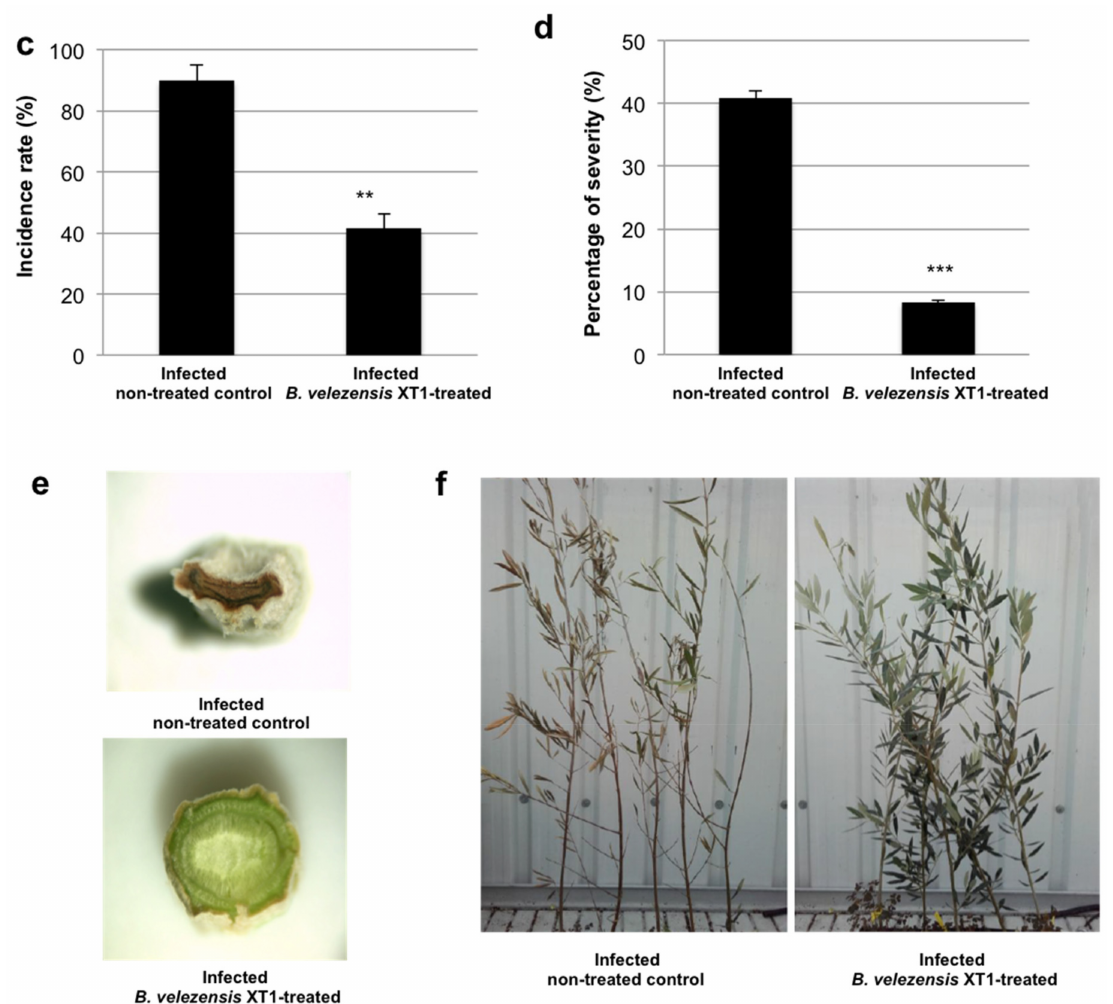
Figure 3. Prevention of Verticillium wilt on young olive trees by Bacillus velezensis XT1. ( a ) PCR amplification of Verticillium dahliae in olive tree leaves. 1: Infected non-treated control, 2: infected B. velezensis XT1-treated plants 30 days after infection, 3: infected B. velezensis XT1-treated